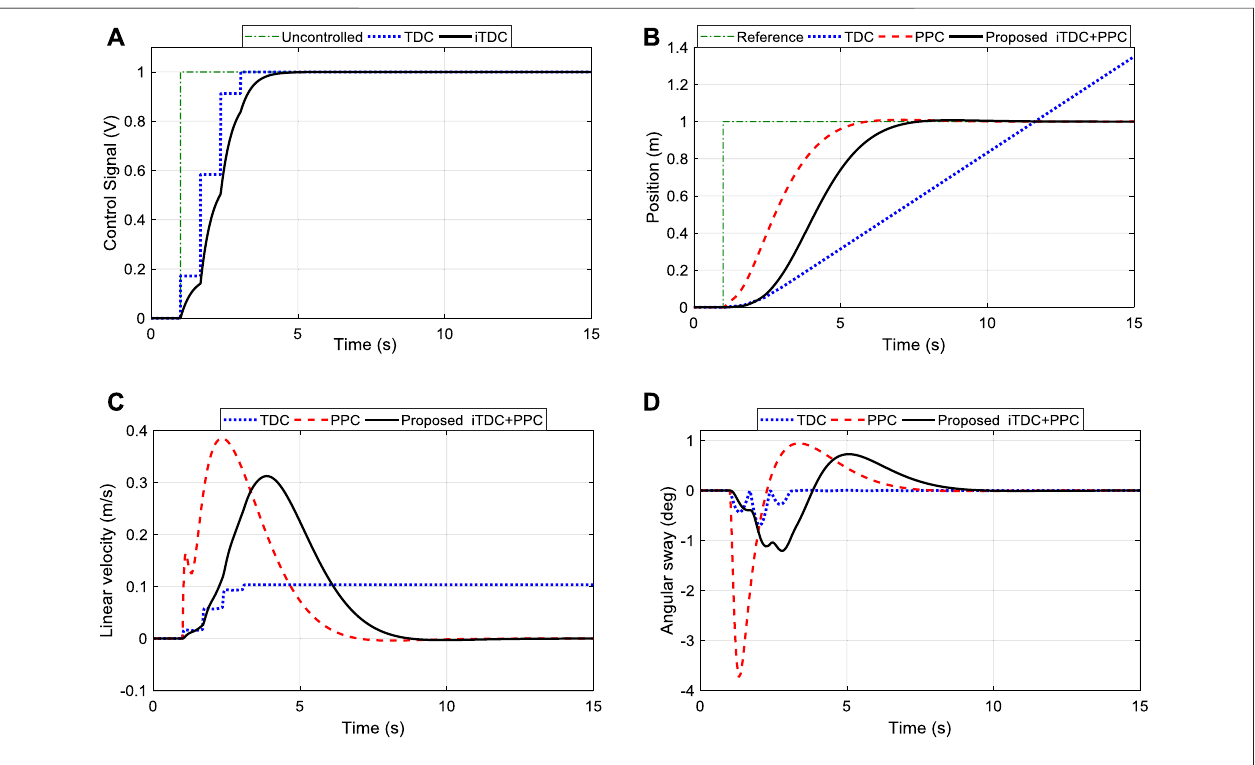
Frontiers in Robotics and AI |